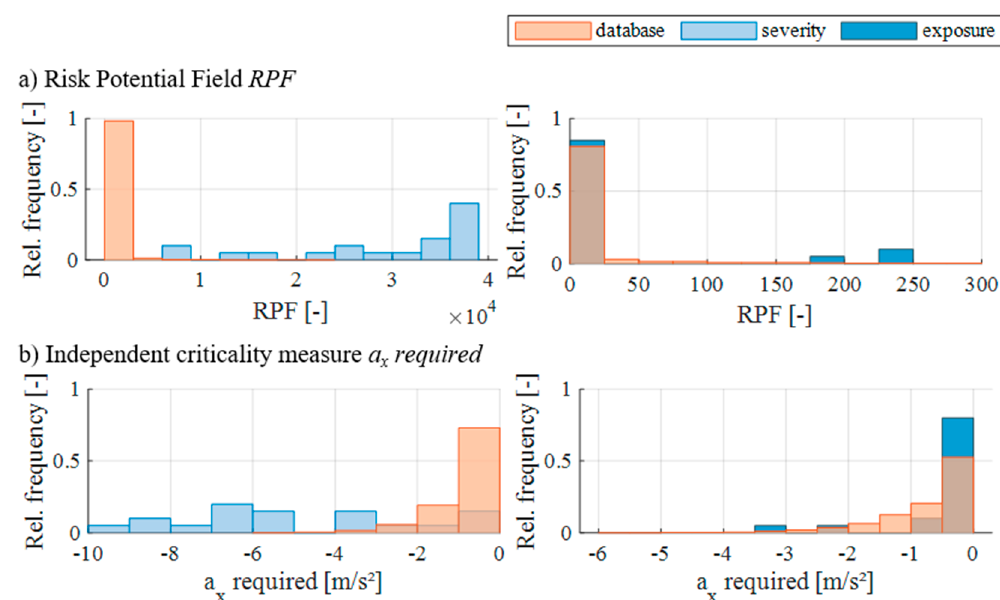
Figure 3. Results of criticality evaluation for severity test suite ( left column) and exposure test suite ( right column), based on two different criticality measures: risk potential field ( a ) and required VuT deceleration ( b ).